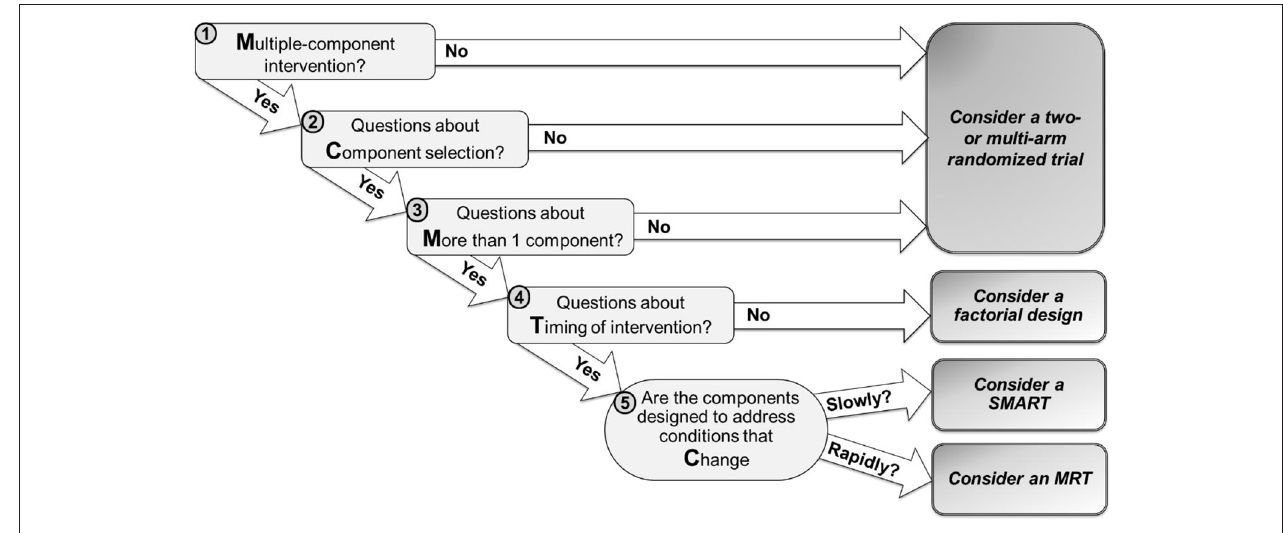
FIGURE 1 | MCMTC: a pragmatic framework for selecting an experimental design to inform the development of digital interventions.